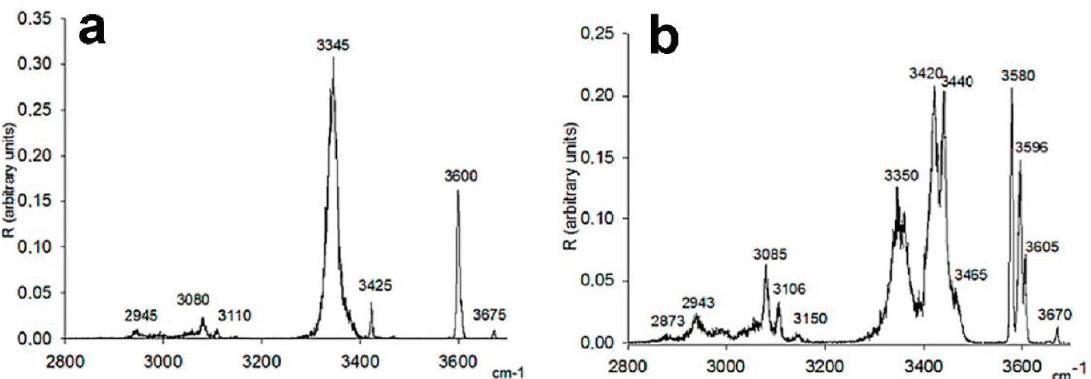
Figure 8. IRMPD spectra of ( a ) [M aR · H · D L ] + and ( b ) [M aR · H · D D ] + [54]. Reprinted with permission from Wiley.